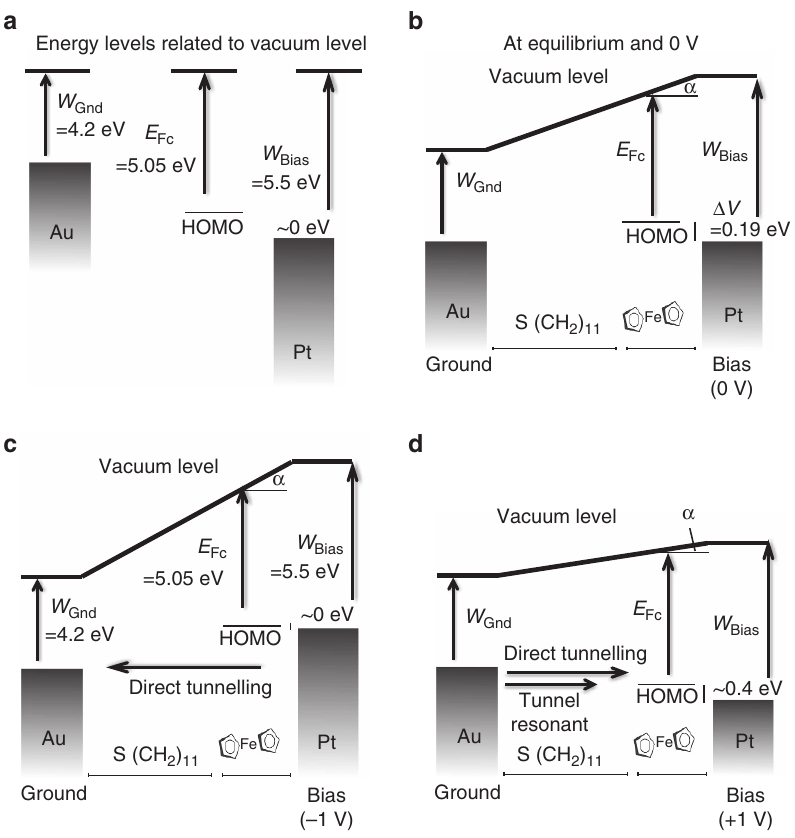
Figure 2 | Sketch of the energetic level of the molecular device. ( a ) Sketch of the energetic level of the molecular device when negative ( (cid:3) 1V) is applied on the Pt tip (see details in Supplementary Information). ( b ) Same as a with 0Vapplied on the tip. ( c ) Same as a with (cid:3) 1Vapplied on the tip. ( d ) Same as a with þ 1V applied on the tip. We considered a coupling parameter of 0.8 to the Fc from the gold atom (80% of the potential drop occurs in the alkyl chain) to calculate the energy shift of the HOMO levels in the junction (see Supplementary Fig. 6 for